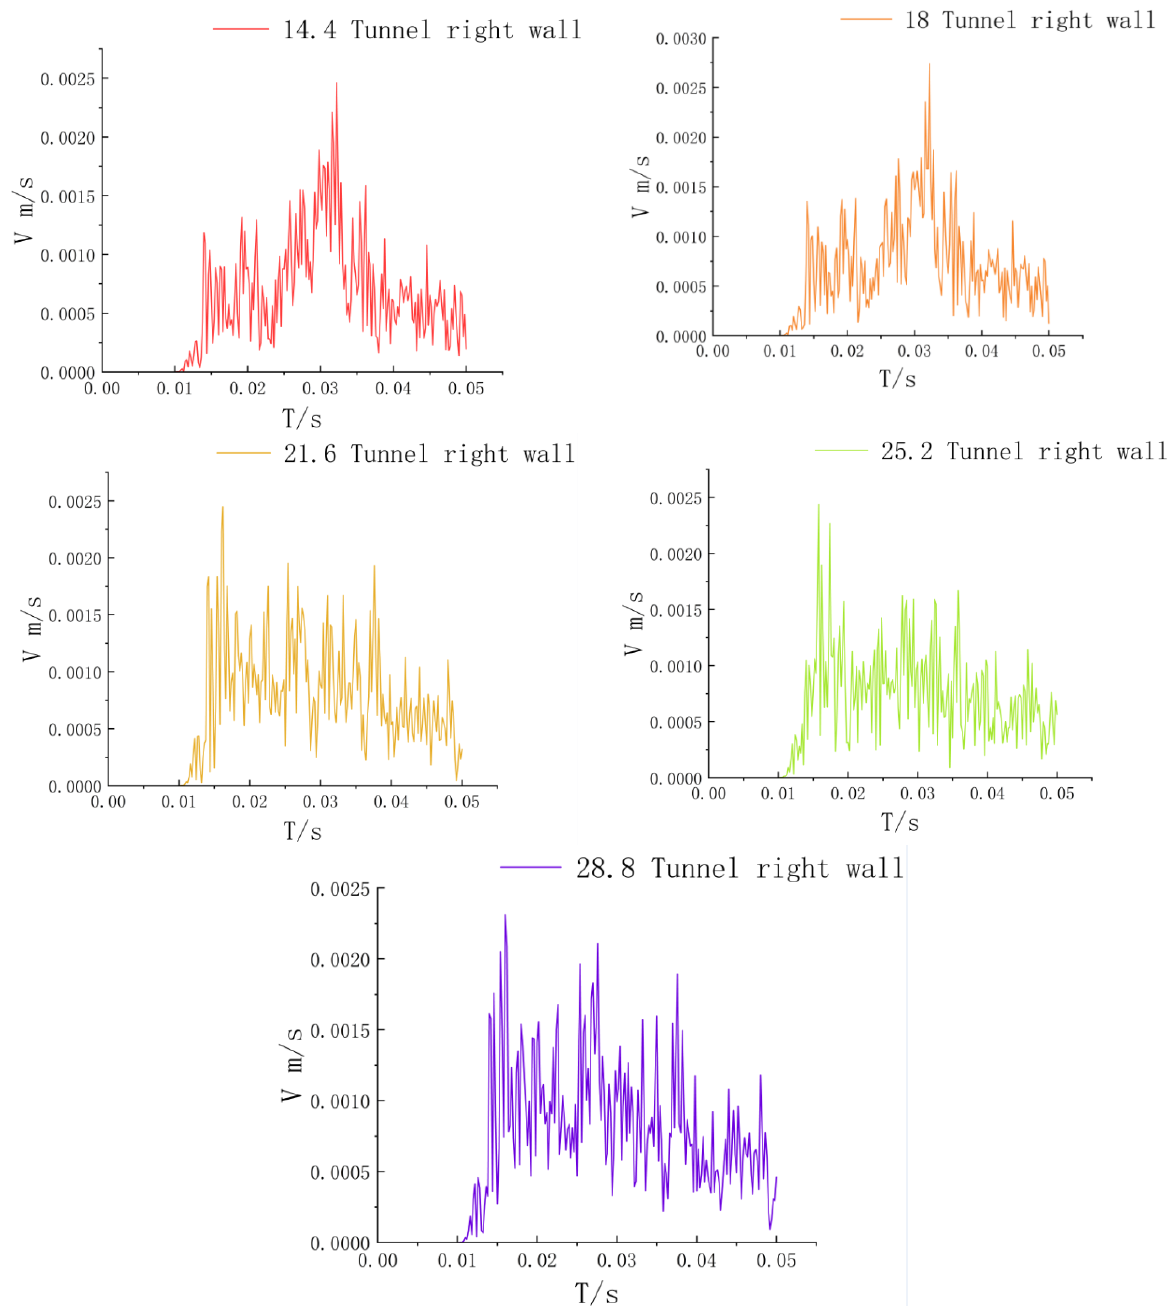
Figure 7. Reinforced concrete tunnel right wall vibration speed curve.